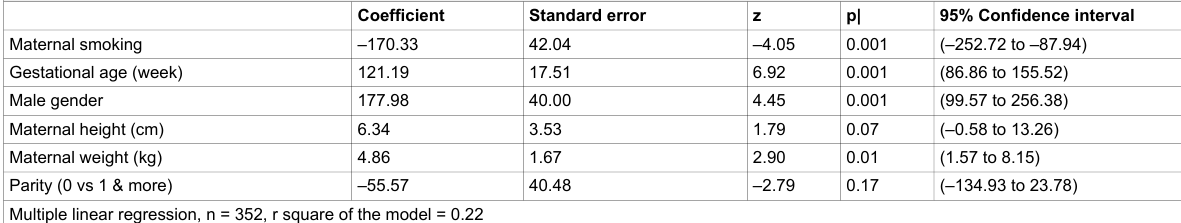
Table 3b: The impact of maternal smoking on the birth weight of term neonates.